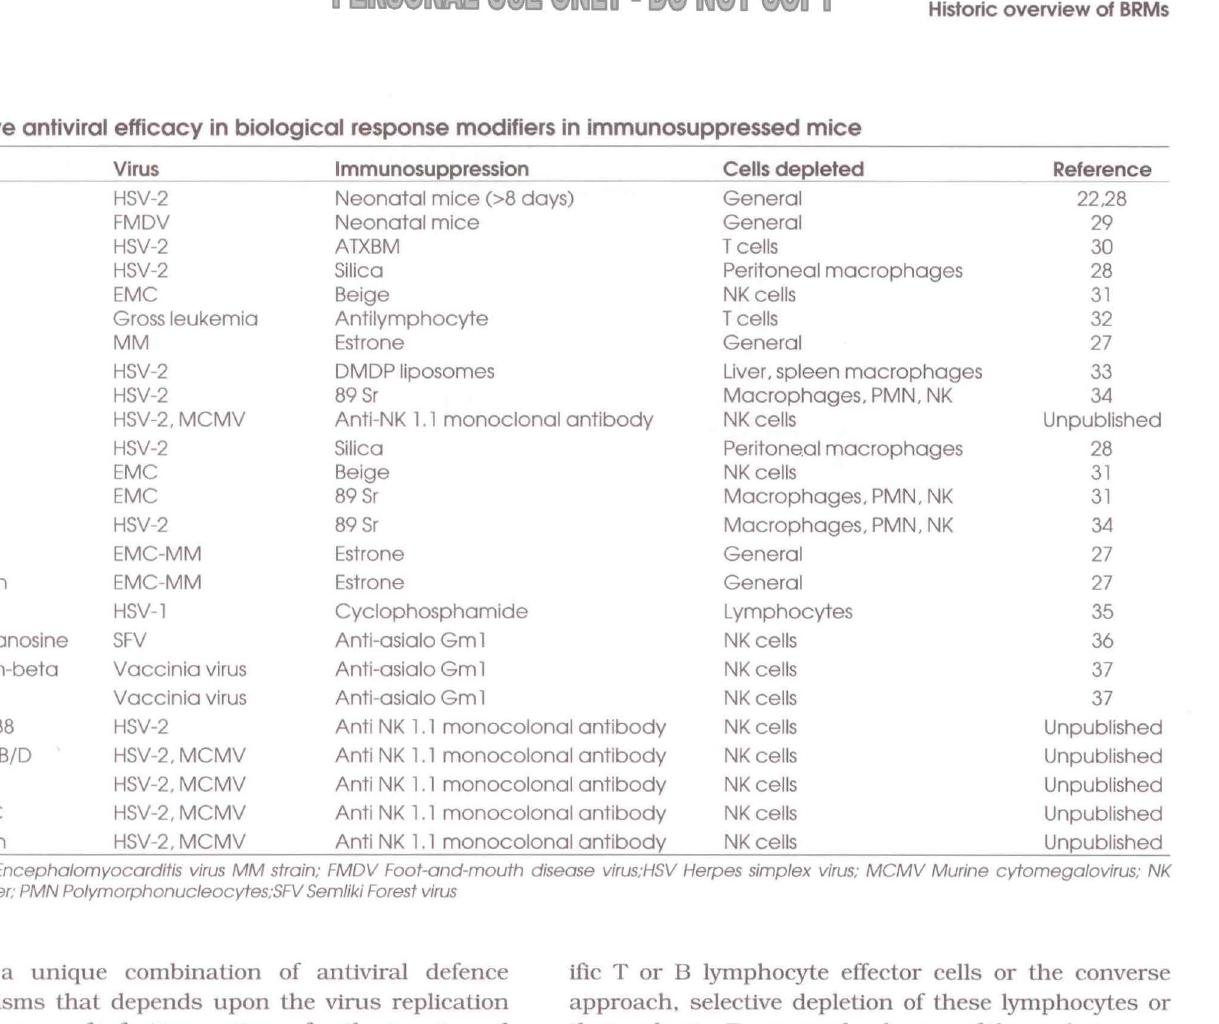
Protective antiviral efficacy in biological response modifiers in immunosuppressed mice BRM